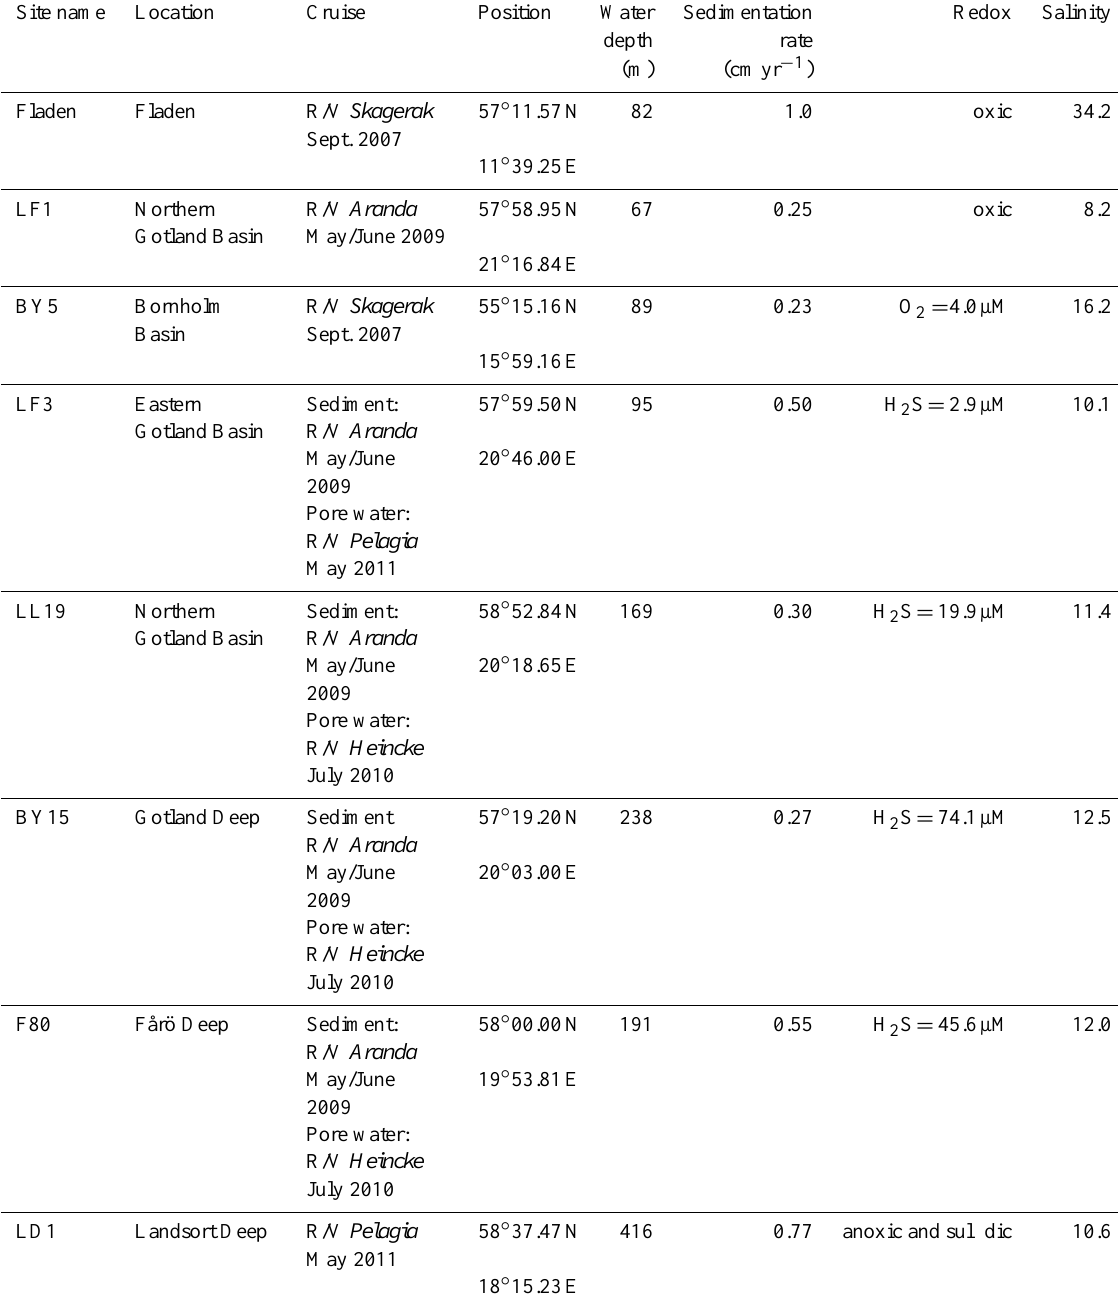
Table 1. Characteristics of the eight study sites in the Baltic Sea. Redox: bottom water redox conditions at the time of sampling. Pore water samples were obtained during every cruise and were similar between years at each station. Here, the most complete data sets for each station are presented. Average sedimentation rates for the last 30 years are based on 210 Pb